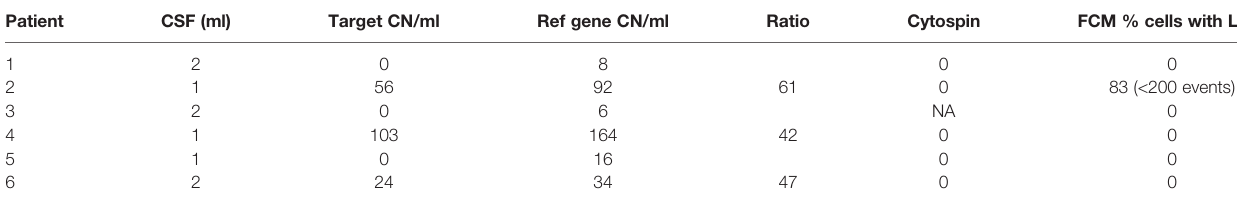
TABLE 4 | CSF results at diagnosis by ddPCR and routine evaluation methods.